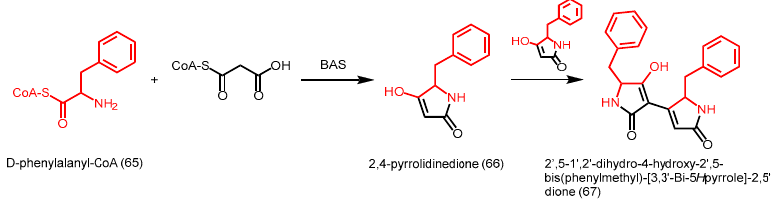
Scheme 23. Novel polyketides catalyzed by R. palmatum